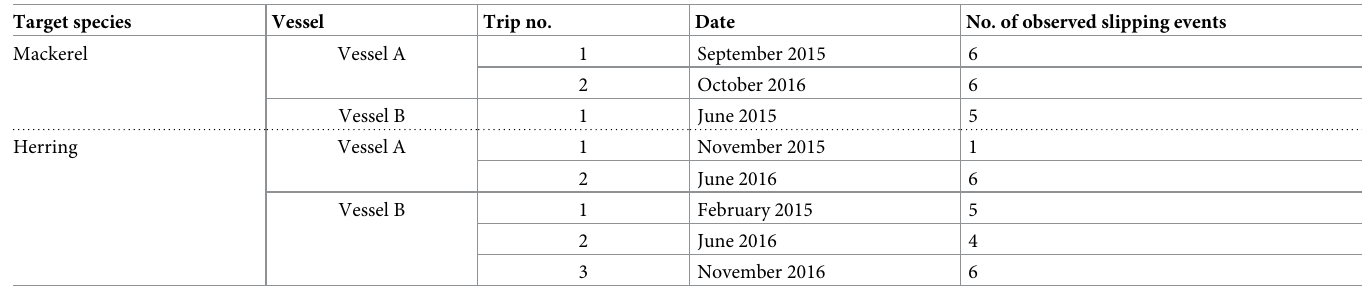
Table 3. Slipping events. Number of observed slipping events of mackerel and herring from purse seines. Target